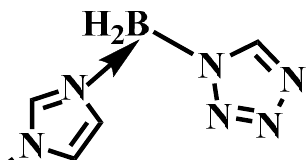
Figure 4. The structure of (1-methylimidazolium)(tetrazol-1-yl)borane.